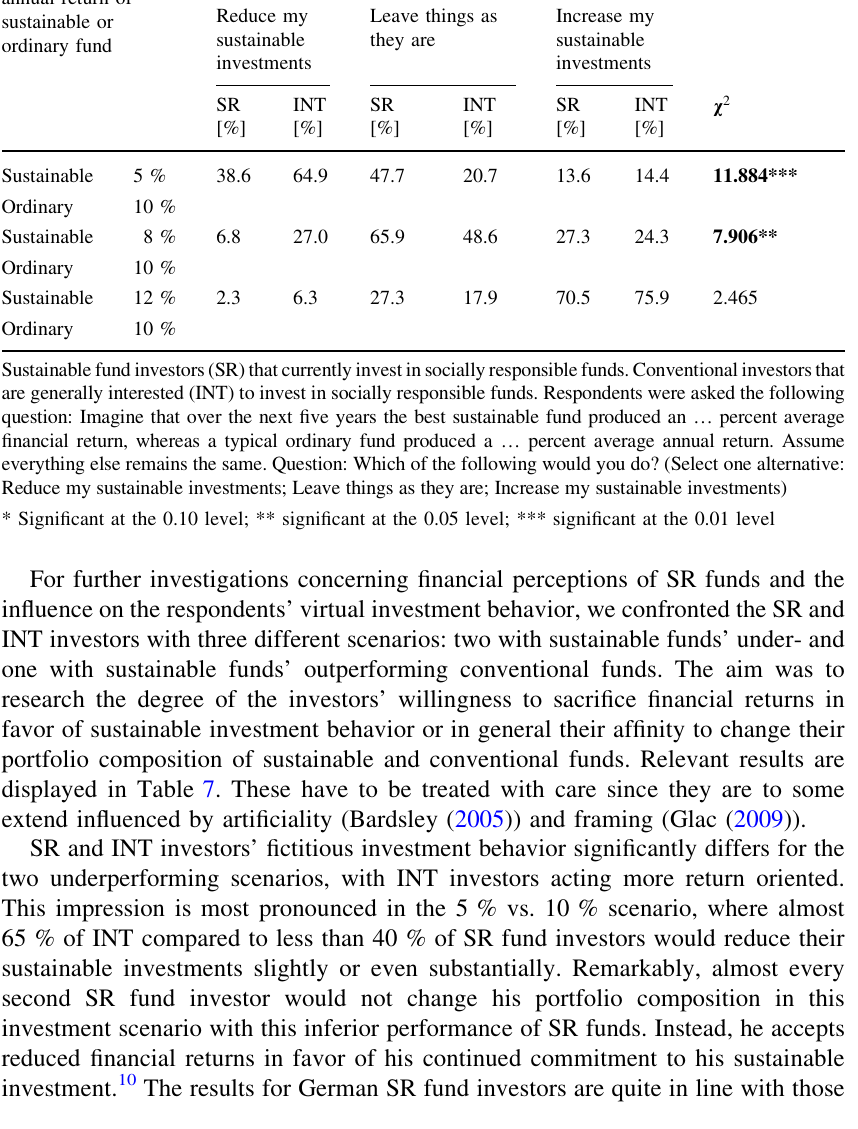
Table 7 Willingness to change the portfolio composition in different performance scenarios 5-year average annual return of sustainable or ordinary